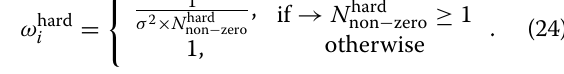
Table 2 The performance of the denoising algorithms with various noise levels